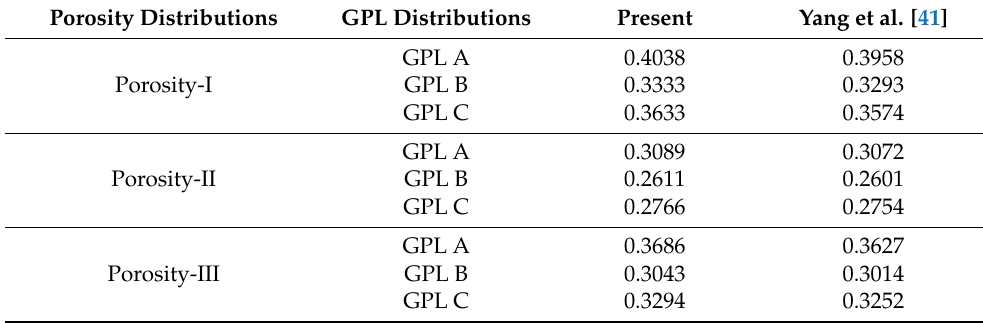
Table 1. Comparison of the dimensionless fundamental frequency of a single GPLRP plate.